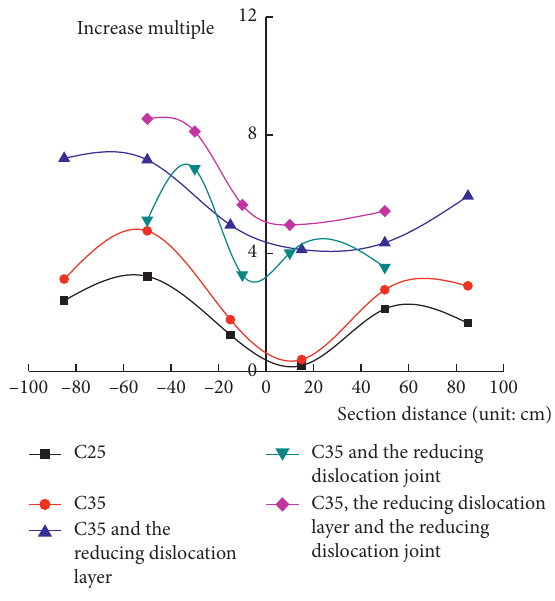
Figure 10: Safety factor of tunnel